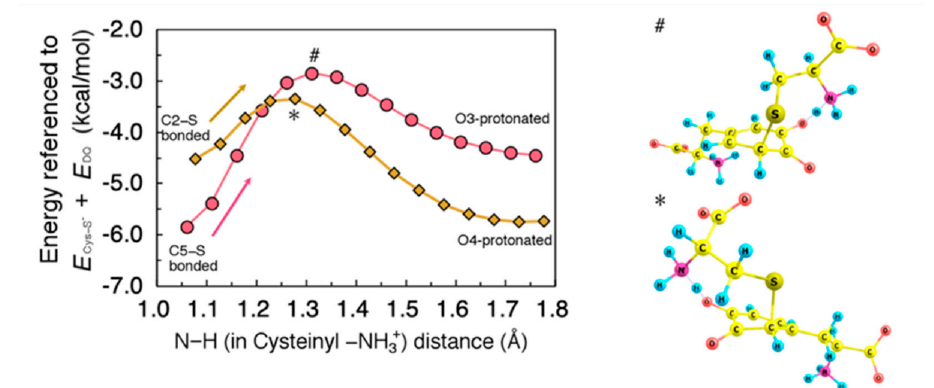
Figure 6. ( Left ) Minimum energy path for proton rearrangement from cysteinyl − NH 3 group in Cys–S − to 3-oxygen (O3) after C5–S bond formation, and 4-oxygen (O4) after C2–S bond formation, plotted as circles and diamonds, respectively. Energies were referenced to the sum of total energy of isolated systems, i.e., Cys–S − and DQ ( E Cys-S − + E DQ ). All geometrical parameters except for the N–H distance were allowed to relax. ( Right ) Transition state structure for O3- (#) and O4- (*) protonation.